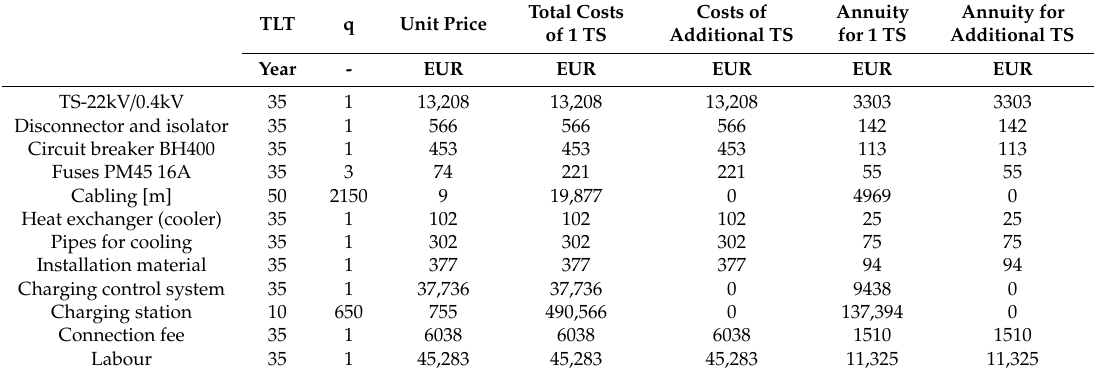
Table 1. Investment costs.